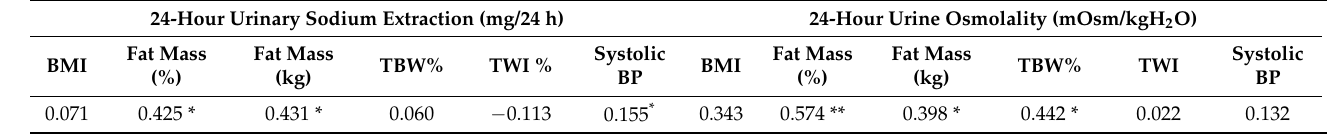
Table 5. Simple linear correlation analysis: 24 h urinary sodium, 24 h urine osmolality, and specified variables (Spearman correlation coefficients